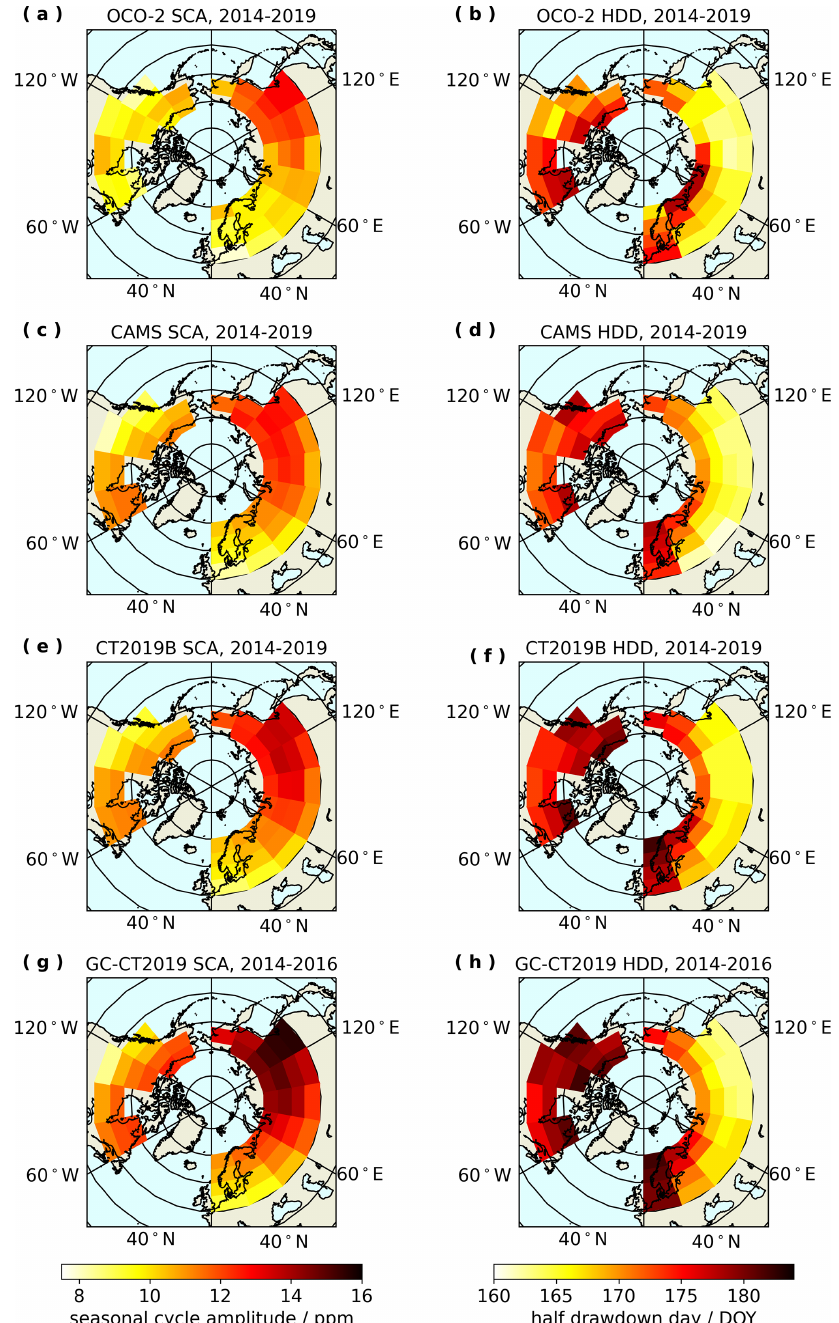
Figure 4. Maps of SCA and HDD (represented as color scaling) from seasonal cycle fits to OCO-2 observations and model estimates from CAMS, CT2019B, and GC-CT2019 for each zone defined in Fig.